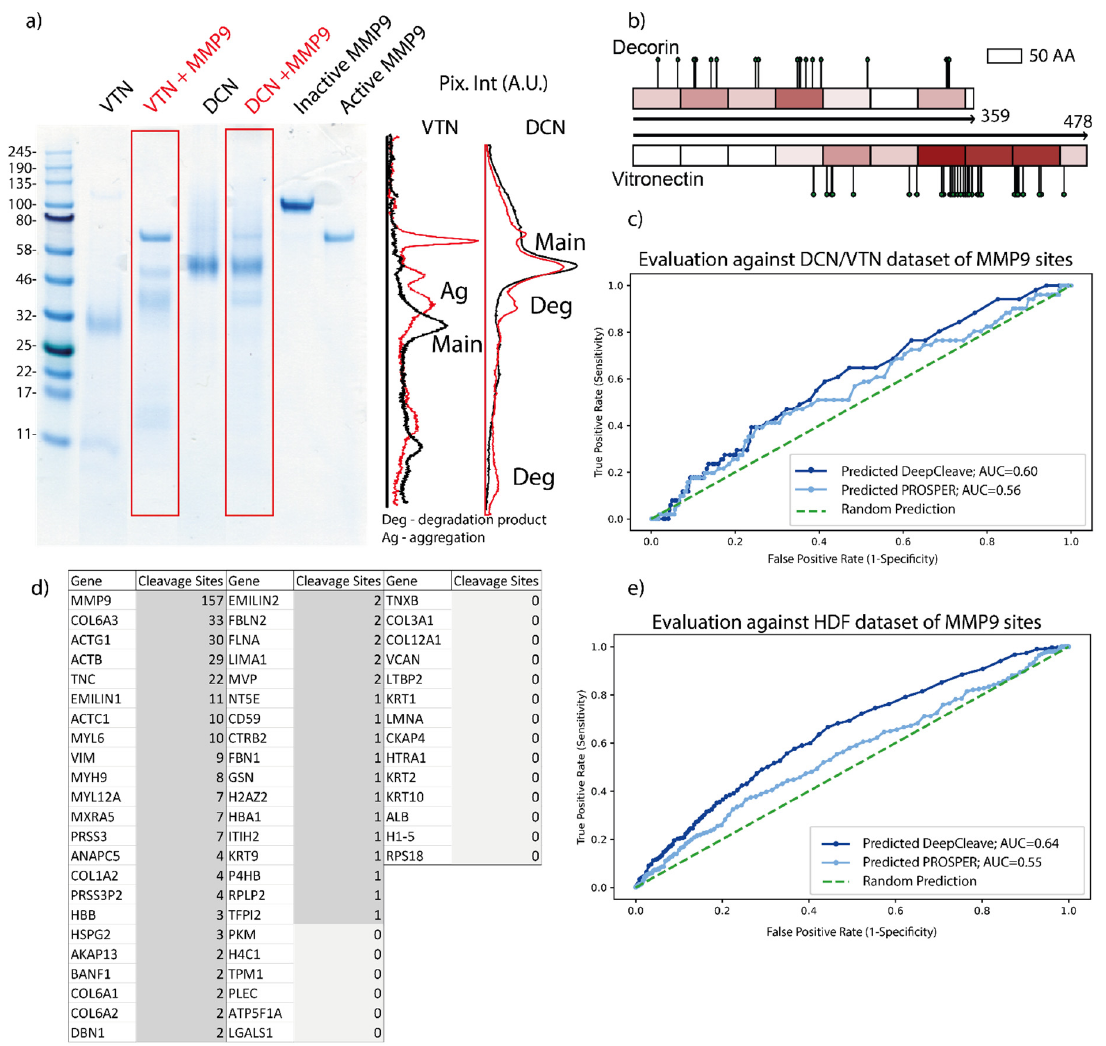
Figure 1. Prediction and validation of protease cleavage sites by existing models. ( a ) Gel-electrophoresis and associated densitometry profiles for control (black) and MMP9-digested (red) vitronectin (VTN) and decorin (DCN) proteins (the apparent Mw of glycosylated DCN is 50 kDa). MMP9 digestion induced profound changes in the electrophoretic profile of VTN. The single ~30 kDa monomer band was replaced by two higher Mw species. In contrast, MMP9 exposure decreased the staining intensity of the 50 kDa DCN monomer band and promoted the formation of putative lower Mw degradation products. ( b ) Differential degradation of VTN and DCN was confirmed by LC–MS/MS on bands excised from the same gel. Pins on the schematics represent experimentally determined cleavage sites, and the heat maps illustrate the number of experimental cleavage sites per 50 AA window (darker red = more sites per window). ( c ) receiver operating characteristic (ROC) curves evaluating experimentally detected MMP9 cleavage sites (by LC–MS/MS) from purified VTN and DCN proteins against protease cleavage site prediction models (PROSPER)- and DeepCleave-predicted cleavage sites. Both algorithms struggled to accurately predict experimental sites in native proteins. ( d ) MMP9-digested proteins detected by LC–MS/MS in a complex cell-derived matrix. A total of 60 proteins were detected, from which 40 had at least one non-tryptic cleavage site (assumed to be due to MMP9). ( e ) ROC curves evaluating experimentally detected MMP9 cleavage sites (by LC–MS/MS) from a complex cell-derived matrix against PROSPER- and DeepCleave-predicted